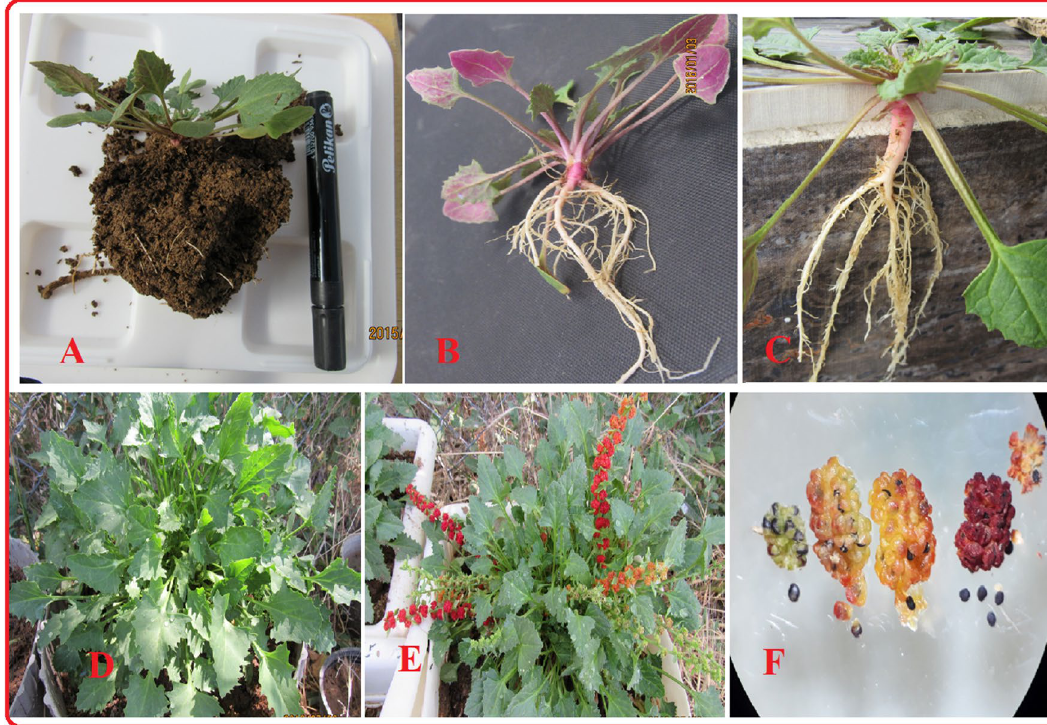
Figure 5. Different stages of greenhouse growing of mass-selected variety. ( A ) Soil profile of seedling, ( B , C ) complete seedling of MSP, ( D ) late of the growing stage, ( E ) fruiting stage, ( F ) development of seeds in fruits.